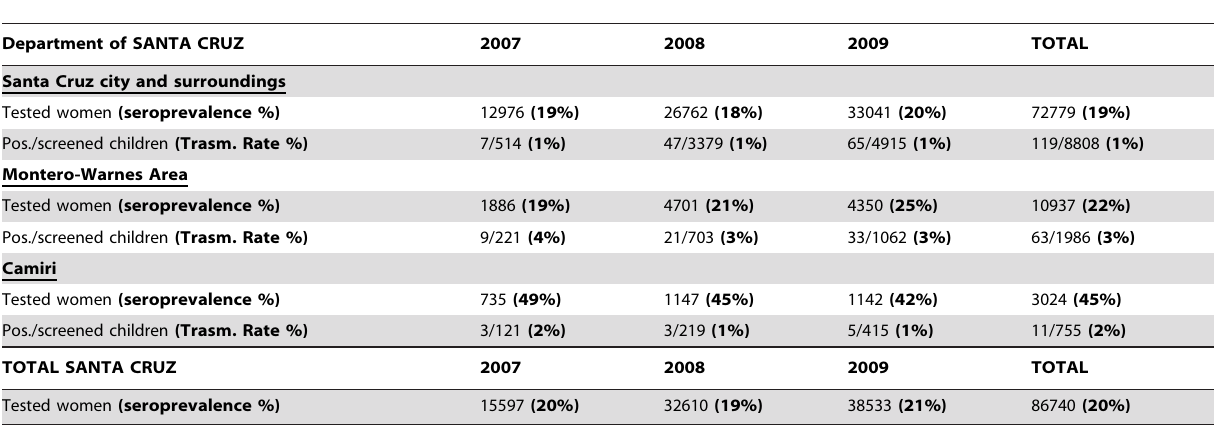
Table 6. Seroprevalence and maternal-fetal transmission rate in the Santa Cruz health facilities.